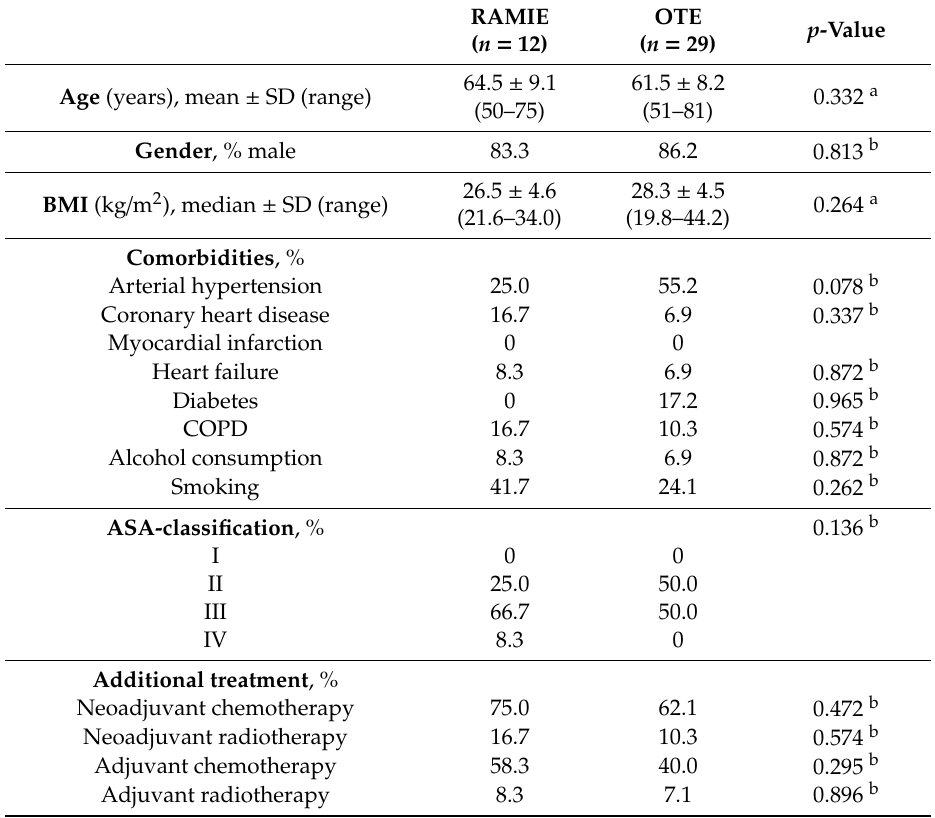
Figure 1. Flow chart of patient inclusion into the study. OTE: open transthoracic esophagectomy; RAMIE: robot-assisted minimally-invasive esophagectomy; HRQoL: health-related quality of life. Table 1. Baseline comparison of all patient characteristic—cohorts stratified by surgical approach (RAMIE vs. OTE).